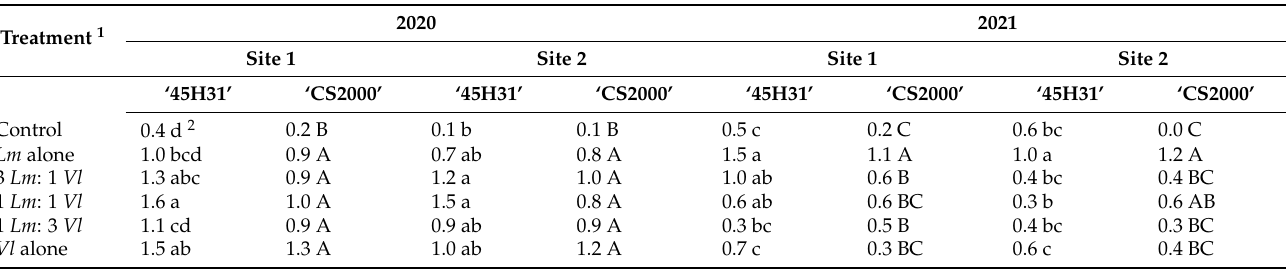
Table 2. Blackleg severity (0–5) on the canola hybrids ‘45H31’ and ‘CS2000’ following inoculation with Leptosphaeria maculans ( Lm ) and/or Verticillium longisporum ( Vl ) alone and in various combinations under field